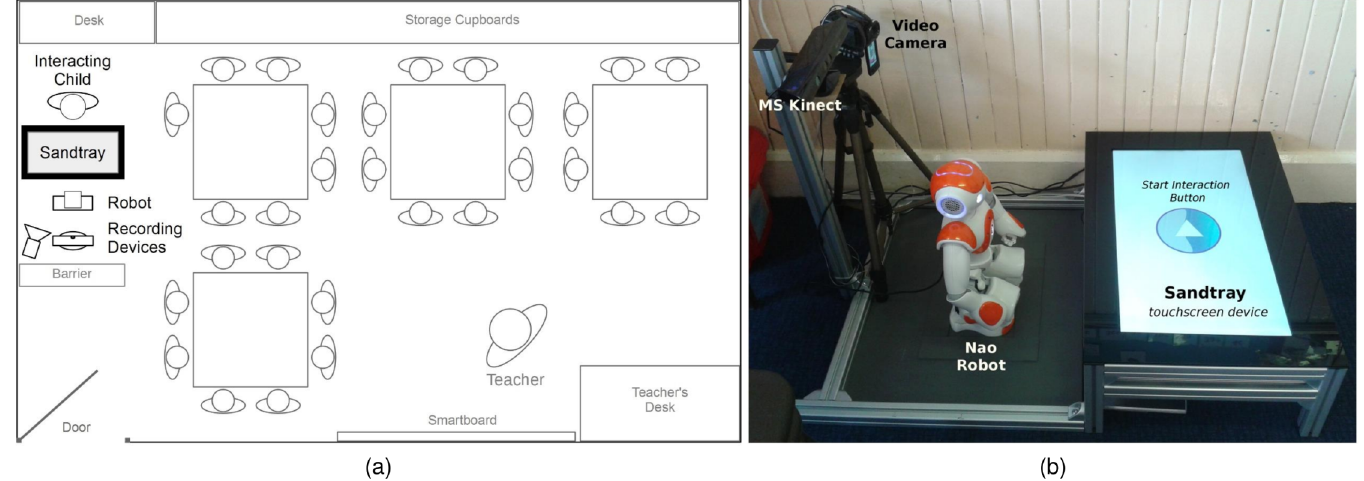
Fig 1. Typical physical setup of the systemwithin the classroom. The robot, Sandtray—atouchscreen device—and camera setup was locatedin one corner of the room in which the childrenhad their normal lessons. Interactions took place duringnormal lesson time. Both classrooms had similar arrangements. Not to